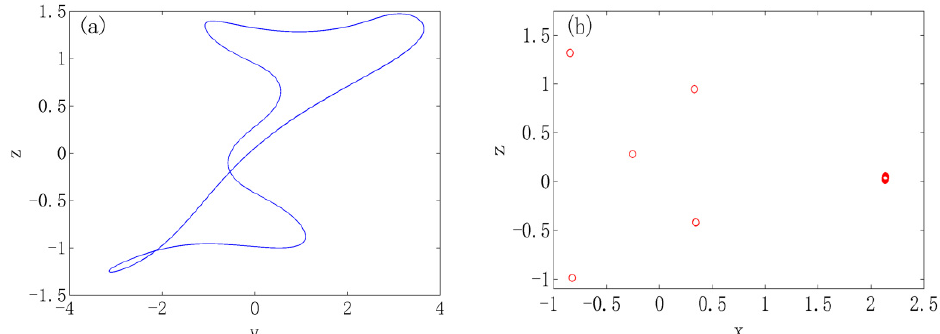
Figure 7. Hidden periodic attractor of system (4) when β = 0.4. ( a ) Phase trajectory diagram in yz plane; ( b ) Poincare map in xz plane.